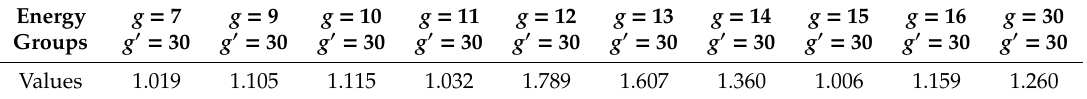
(cid:16) (cid:17) (cid:48) σ g , σ g , g , g (cid:48) = 1, ... ,30 having values greater than 1.0. t , i = 1 t , k = 5